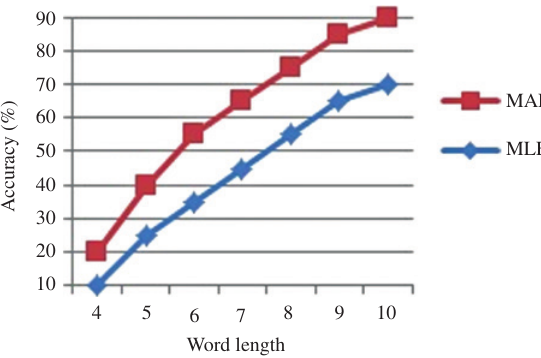
Figure 10: Accuracy between MLE and